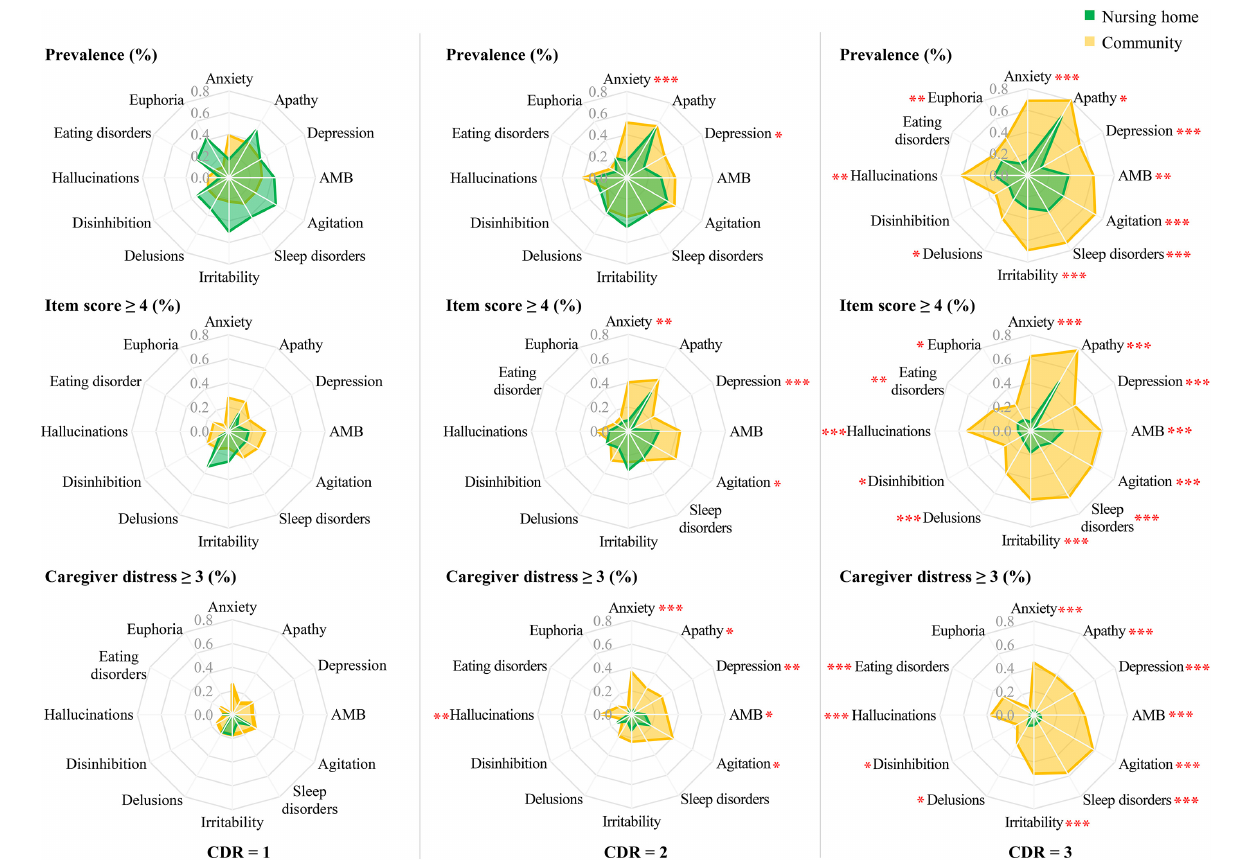
FIGURE 3 | Comparisons of prevalence and clinical significance of BPSD (item score ≥ 4), and moderate-to-severe caregiver distress (distress score ≥ 3) caused by these symptoms, between community-dwelling older adults with dementia and nursing home residents with dementia, by severity of dementia. BPSD, behavioral and psychological symptoms of dementia; CDR, Clinical Dementia Rating. ∗ P < 0.05, ∗∗ P < 0.01, ∗∗∗ P <